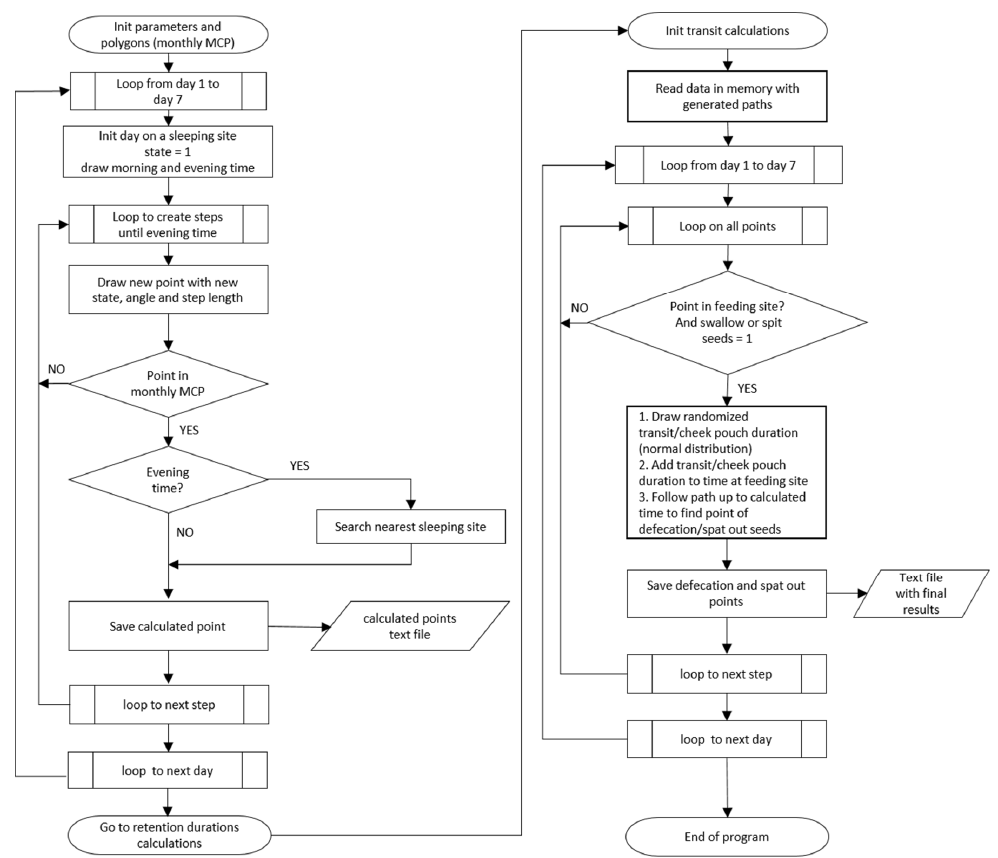
Figure 1. Mechanistic MOdel of Seed Transfer (MOST) algorithm used in Fortan program for northern pigtailed macaques in Sakaerat.